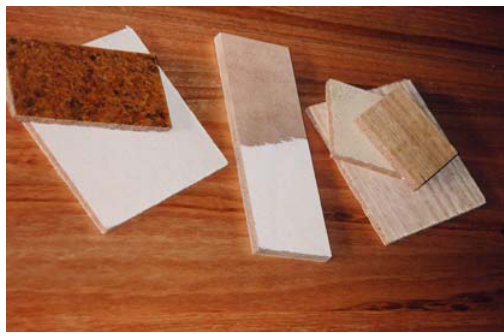
Figure 4. Samples of cork/thermoplastic